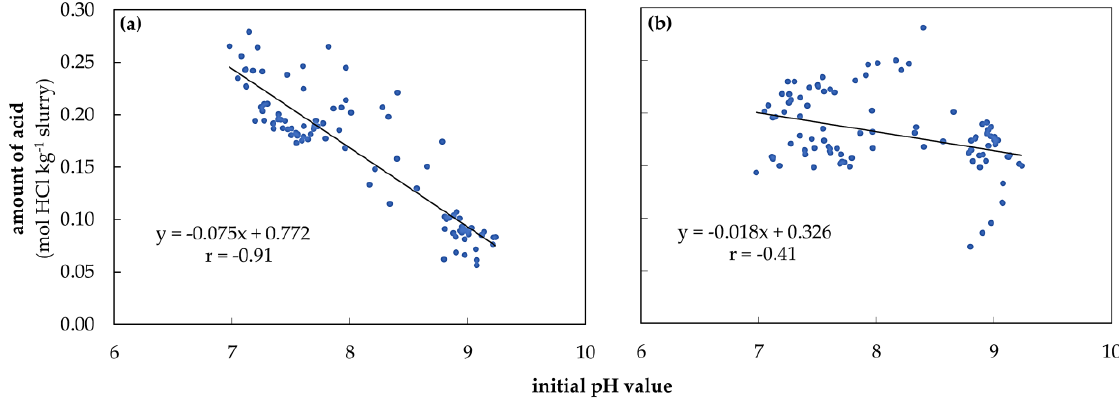
Figure A2. Amount of acid in pH range 5.5 to 3.0 (VFA buffer) ( a ) and in pH range 7.0 to 5.5 (HCO 3 − buffer) ( b ) in dependency of initial pH value (n = 105).